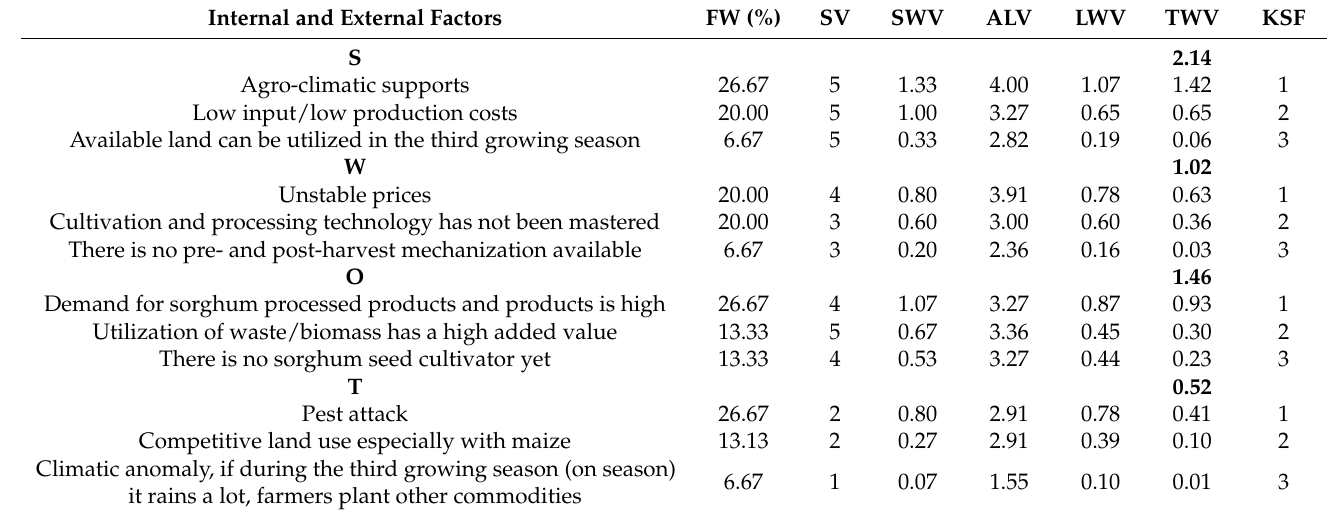
Table 5. Evaluation of internal and external factors in sorghum development in Wonogiri Central Java,